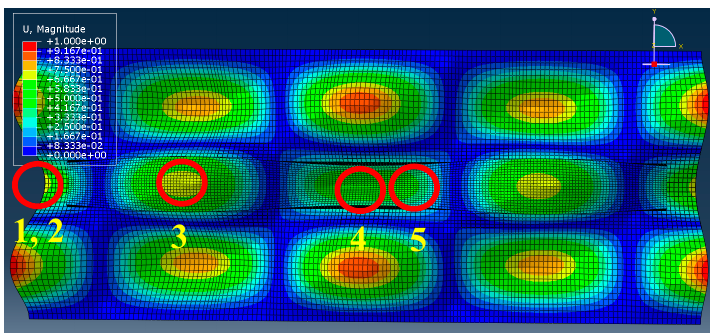
Figure 9. Mode 23 predicted by the frequency analysis of the numerical model.